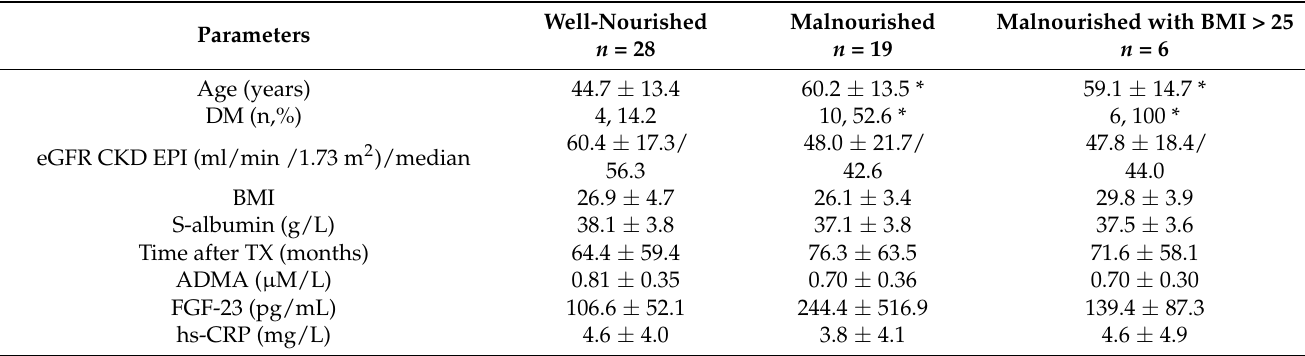
Table 3. The comparison between well-nourished and malnourished